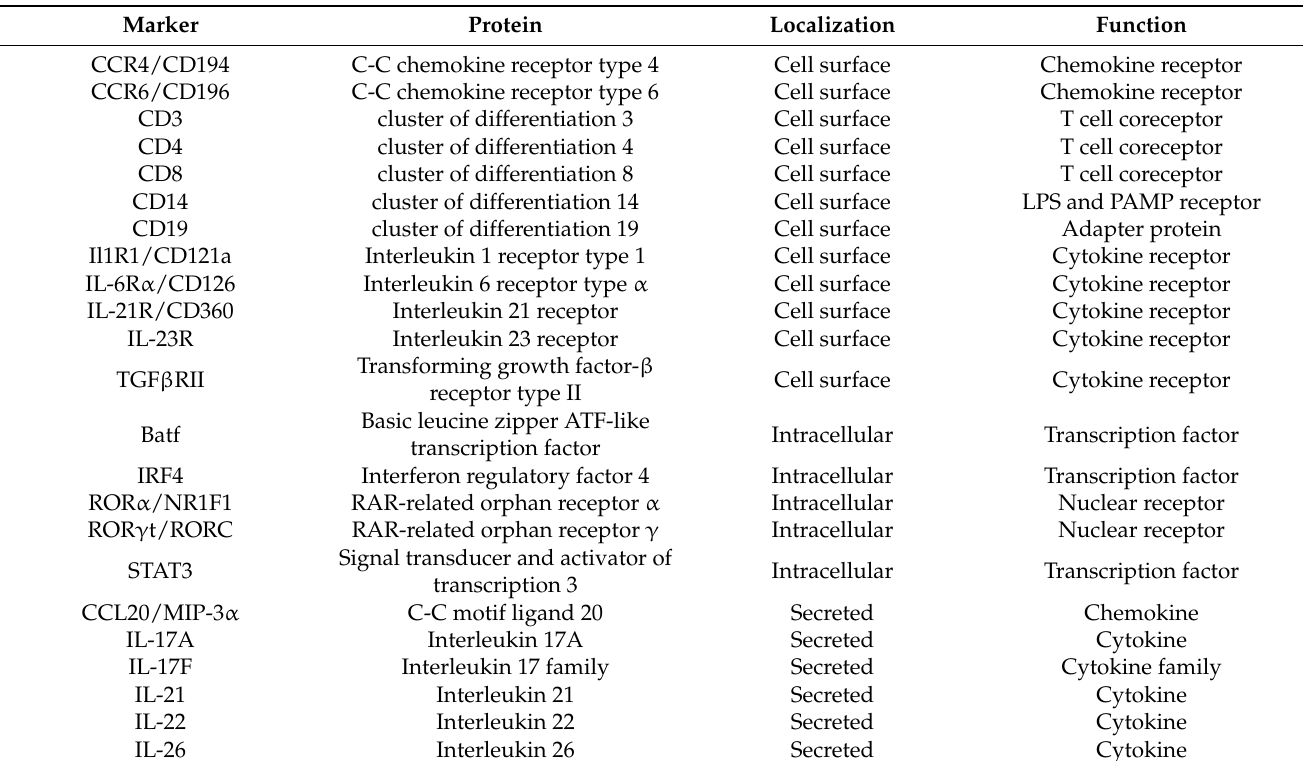
Table 1. Immunophenotyping of human Th17 cells by flow